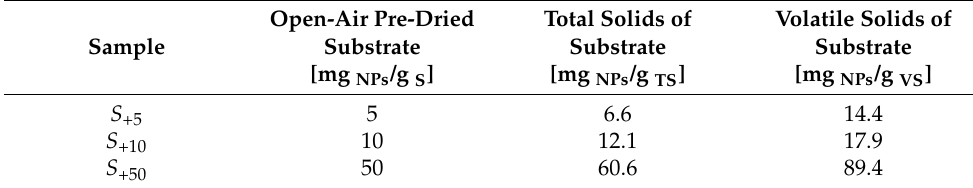
Table 1. Dosage of NPs at different measure units.